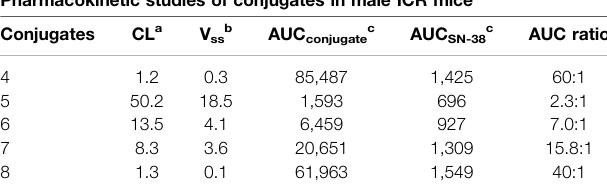
( Table 2 ). Different exo -BCN components, 13 for conjugate 5